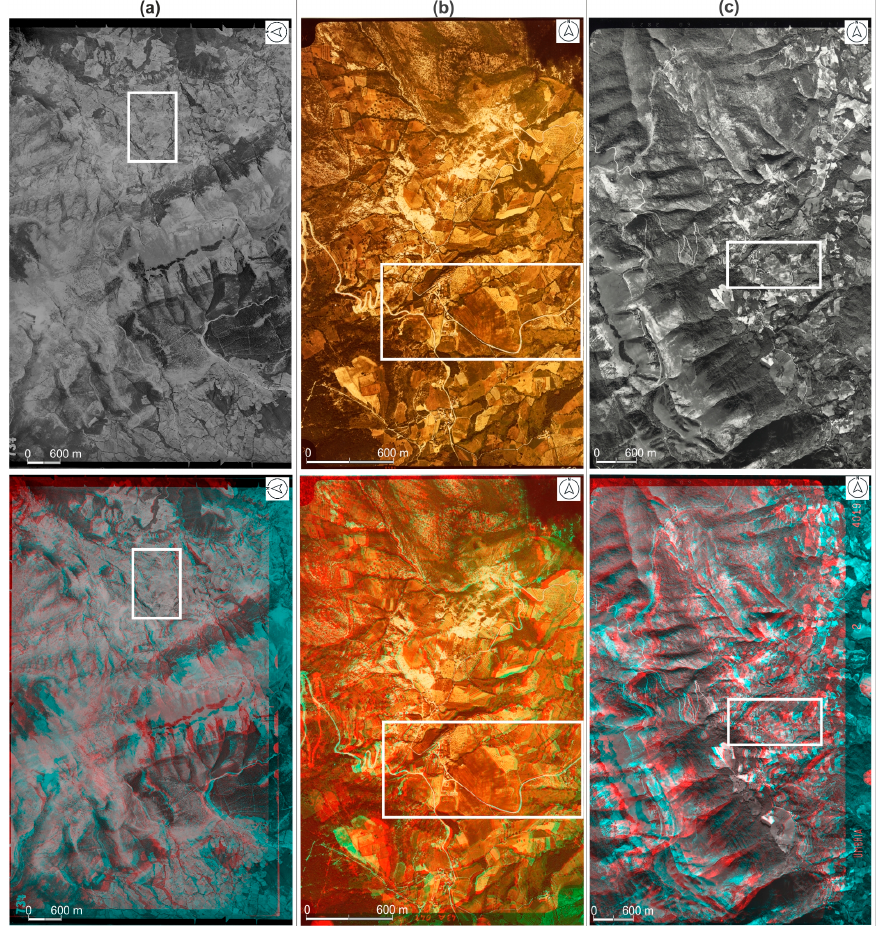
Figure 5. Multitemporal photo aerial images with anaglyphs generated with StereoPhoto Maker software (3D glasses for proper viewing are required). ( a ) AR 06–“Volo GAI” B/W 1954 photogram 734 with the anaglyph beneath built with flights 734–735; ( b ) “Volo Umbria a colori” photogram 43A-50 with the anaglyph beneath built with flights A43–49 and A43–50; ( c ) “Volo AR34” B/W 1997 photogram 2-4020 with the anaglyph beneath built with flights 2-4019 and 2-4020. The white boxes indicate the study area.